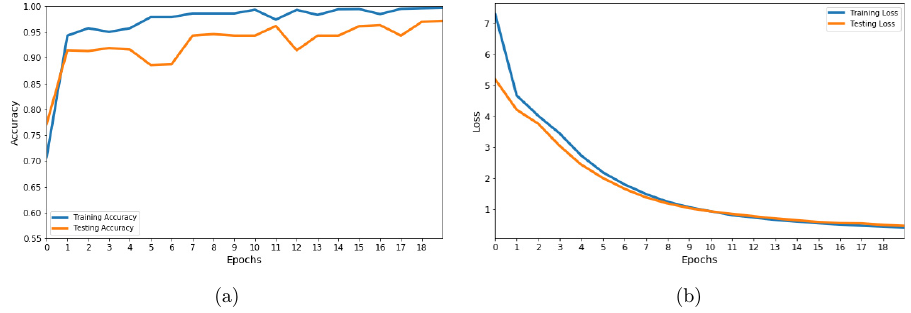
Fig. 13. Graph of the ResNet50 þ LSTM model: (a) Epochs vs. Accuracy (b) Epochs vs.